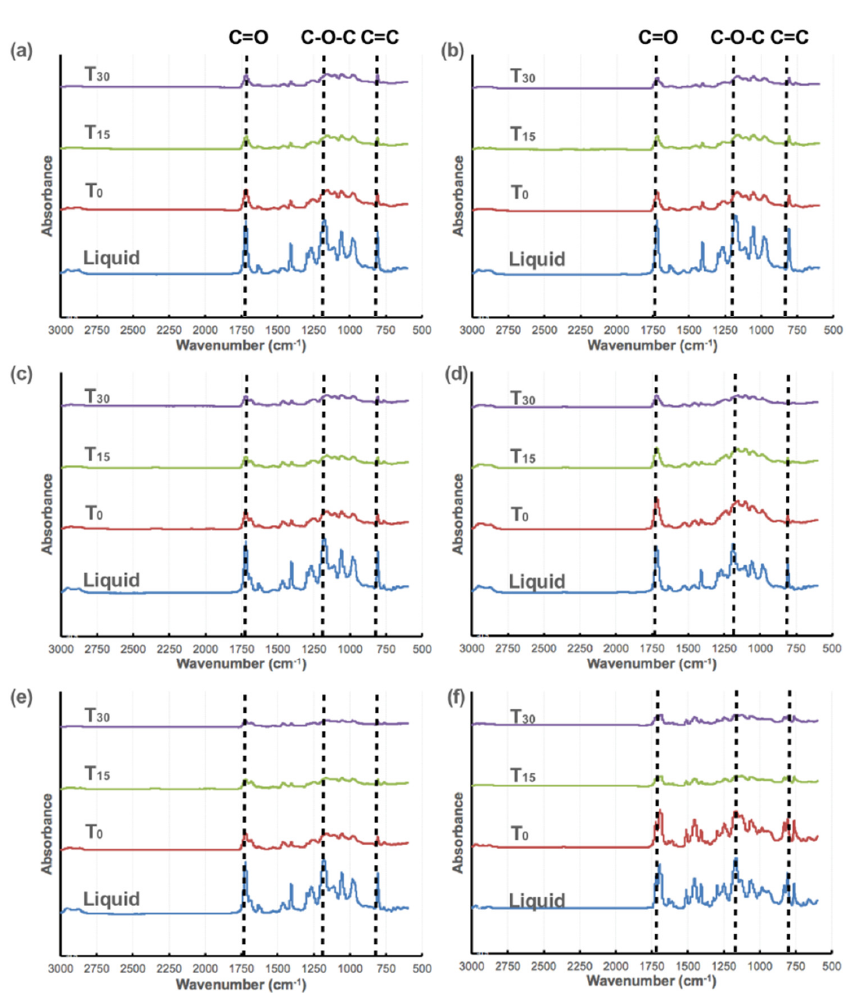
Figure 3. Fourier transform infrared spectrum of ( a ) 87A, ( b ) 88A, ( c ) 588, ( d ) 594, ( e ) 5812, and ( f ) a BB base.